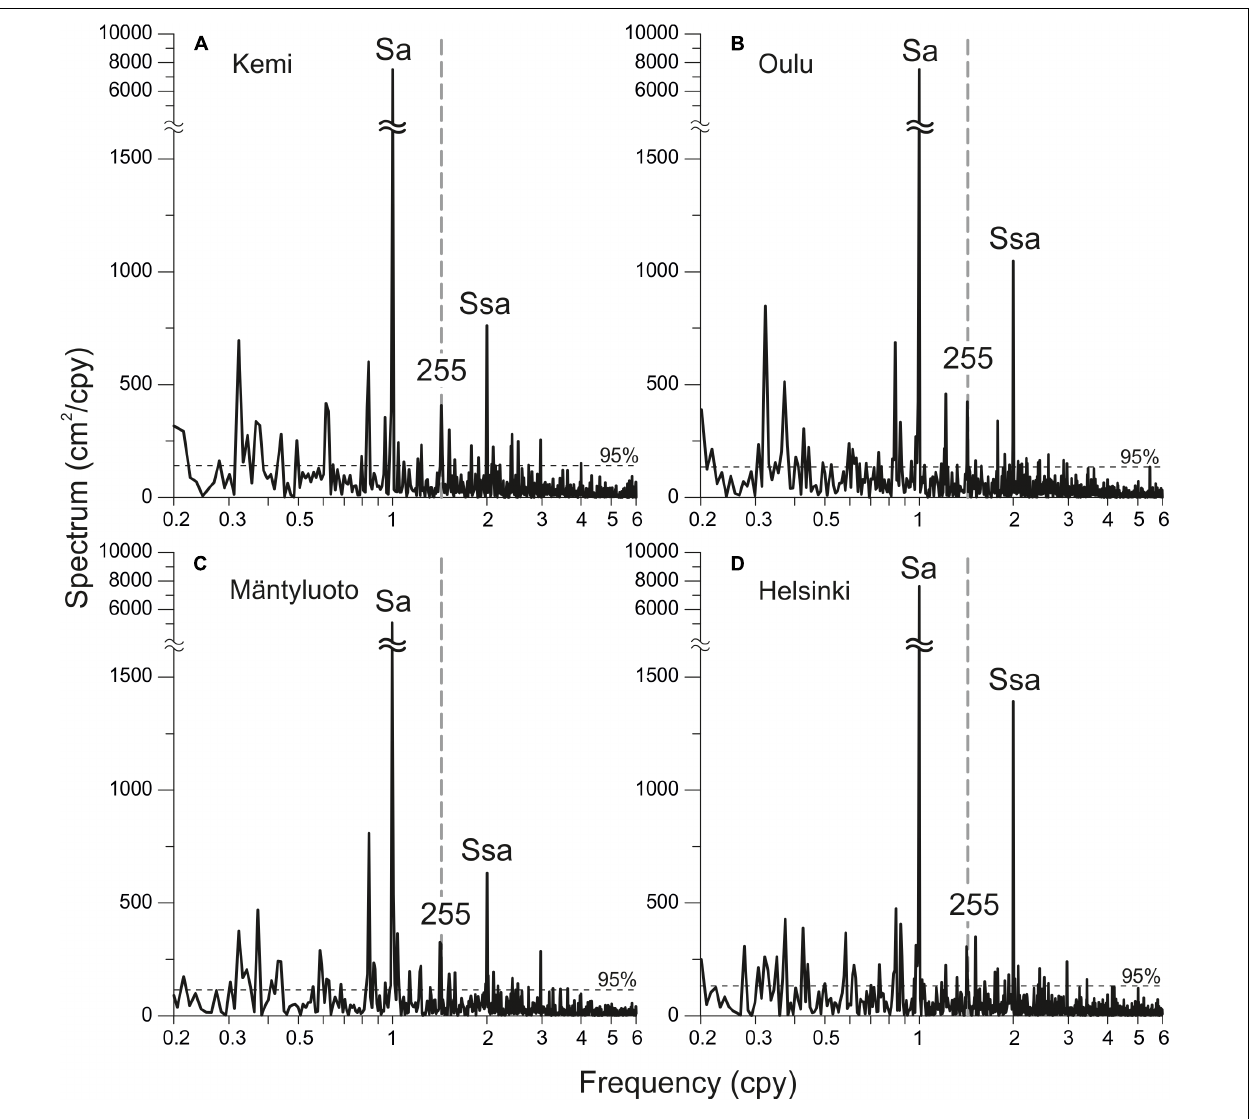
FIGURE 6 | The sea level spectra estimated from mean monthly sea level records at (A) Kemi, (B) Oulu, (C) Mantyluoto, and (D) Helsinki. Labels “Sa,” “Ssa,” and “255” mark annual, semiannual, and 255-daily spectral peaks, respectively. Thin dashed lines show 95% significance level calculated according to Chi-squared